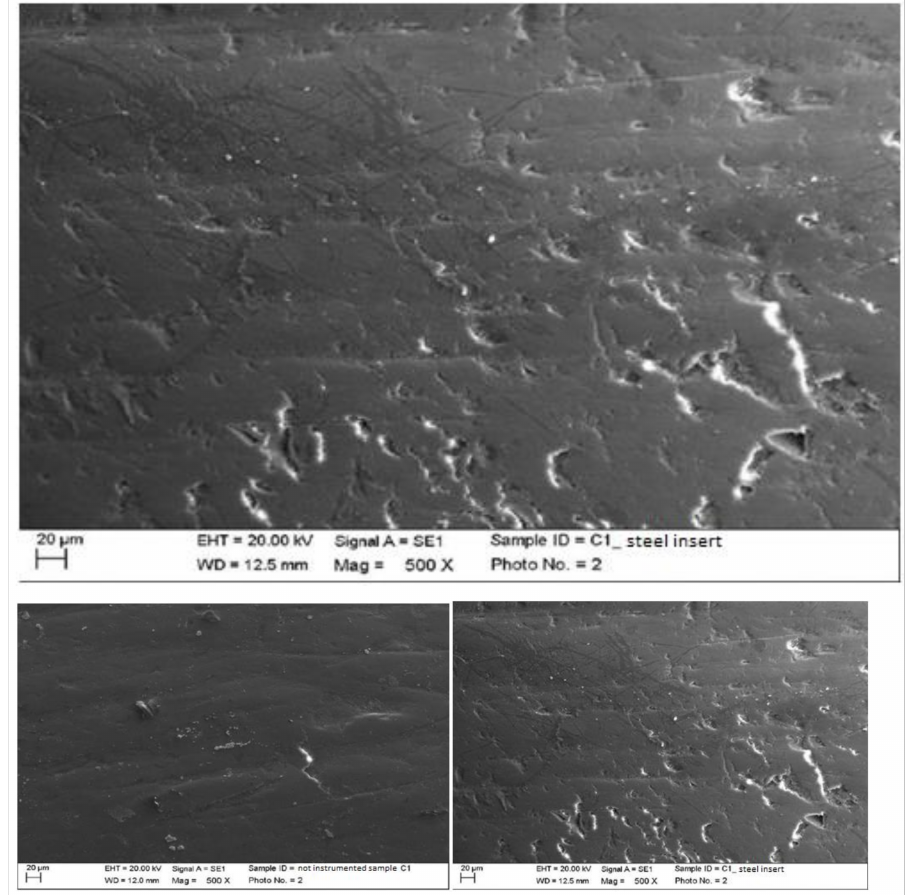
Figure 6. Instrumented composite sample C1 with steel insert (500 × ). Comparison before/after instrumentation.